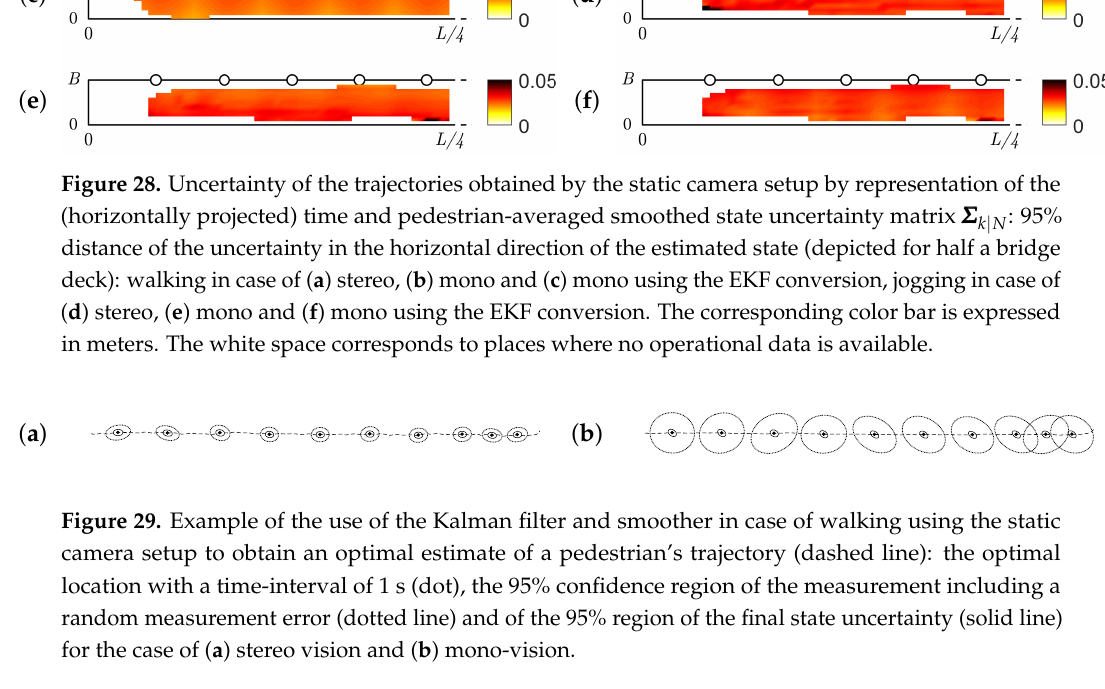
Figure 29. Example of the use of the Kalman filter and smoother in case of walking using the static camera setup to obtain an optimal estimate of a pedestrian’s trajectory (dashed line): the optimal location with a time-interval of 1 s (dot), the 95% confidence region of the measurement including a random measurement error (dotted line) and of the 95% region of the final state uncertainty (solid line) for the case of ( a ) stereo vision and ( b ) mono-vision.